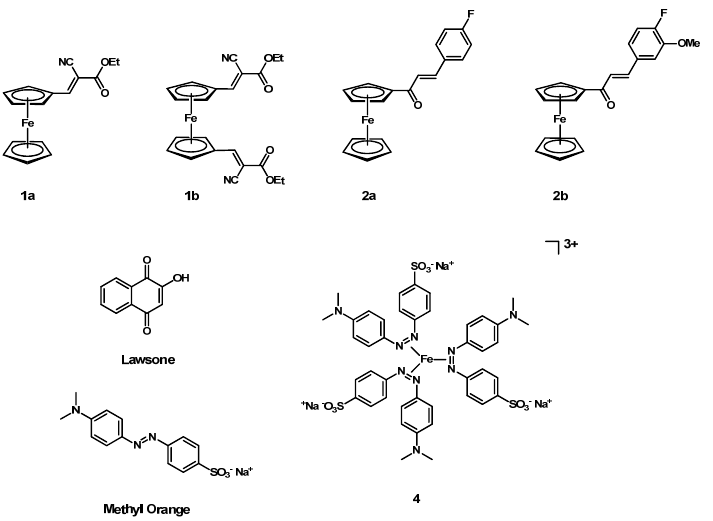
Figure 3. Structure of dyes 1a – b , 2a – b and 4 , of Lawsone and of Methyl Orange. Compound 1a , due to the presence of only one acceptor, showed a reversible oxidation process (+0.61 V vs. Saturated Calomel Electrode (SCE)), whereas compound 1b was oxidized with greater difficulty (+0.87 V vs. SCE) because of the presence of two cianovinyl chains. Dye 1a also showed a higher molar extinction coefficient ( ε ) than 1b .